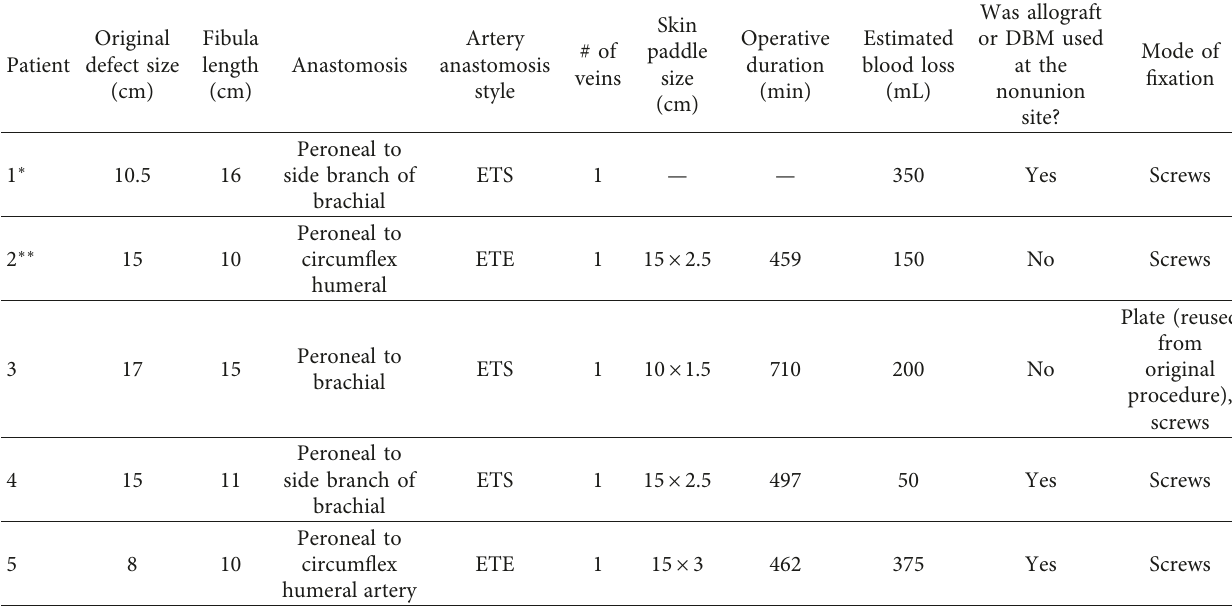
Table 1: Free vascularized fibular flap (VFF) operative details.